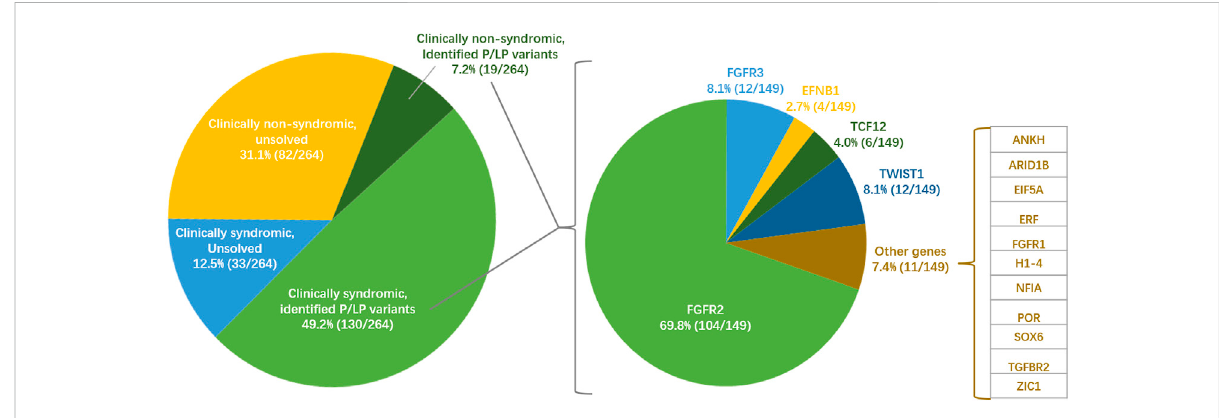
FIGURE 2 Situation of clinical diagnosis, genetic diagnosis and pathogenic genes of craniosynostosis in the Chinese cohort of this study ( n = 264) . Thepiechartontheleftshowsabroadclassi fi cationbasedonclinicaldiagnosisandgeneticdiagnosisinthisstudy.Thepiechartontheleftshowsthe diagnosis contribution of 16 pathogenic genes in positive genetic